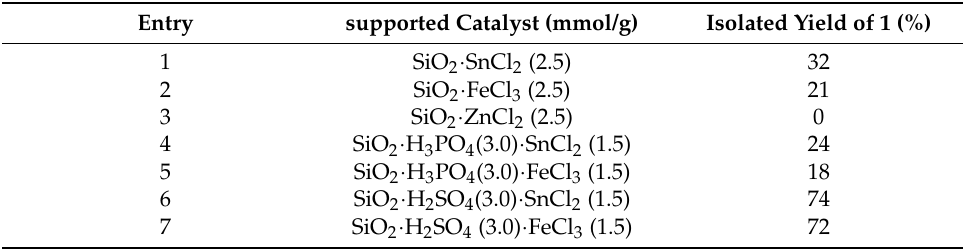
Table 4. Catalytic activity of supported Lewis